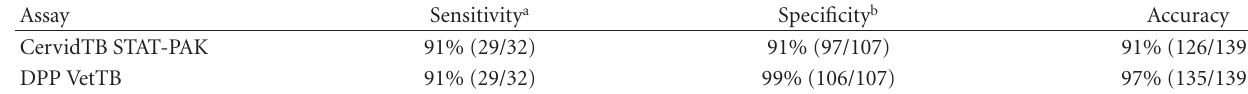
Table 3: Diagnostic performance of serological tests in fallow